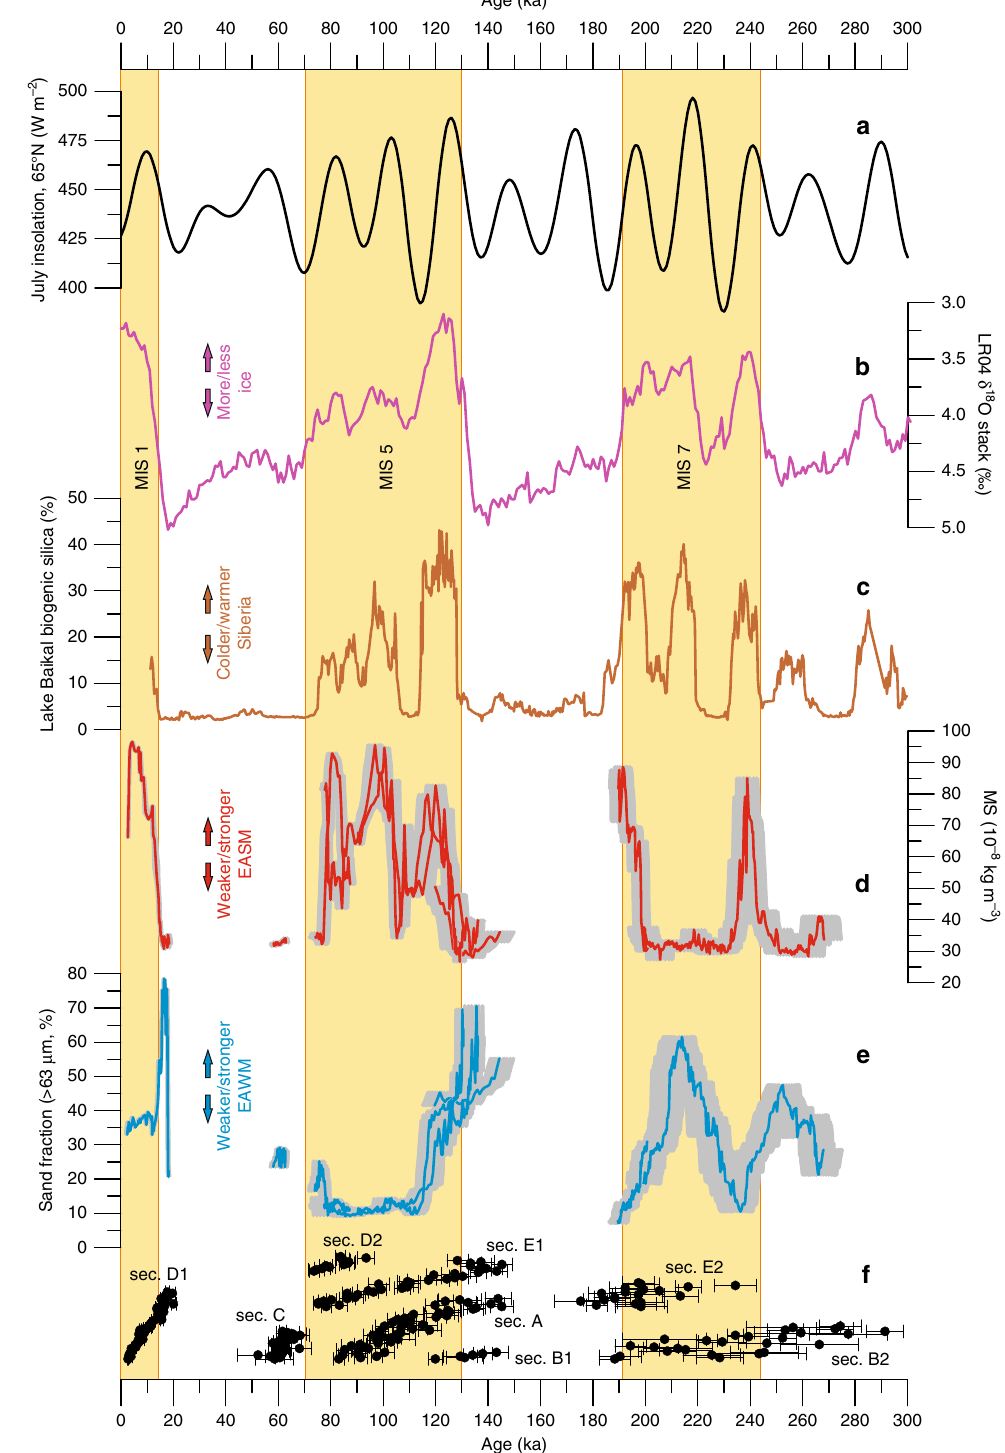
Fig. 3 Comparison of global/Northern Hemisphere proxy records with the Jingbian records on independent timescales for the last 300 ka. a 65°N July insolation 22 record, b benthic LR04 δ 18 O stack 23 , c Lake Baikal biogenic silica 13 record and d low- fi eld magnetic susceptibility (MS) and e sand content (>63 µ m) of the Jingbian loess – paleosol record. Individual luminescence age determinations for each section are shown in f with 1 s.d. age uncertainties. Grey shading behind the MS/sand fraction curves indicates 1 s.d. age model uncertainties. Marine oxygen isotope stages/boundaries shown are from Lisiecki and Raymo